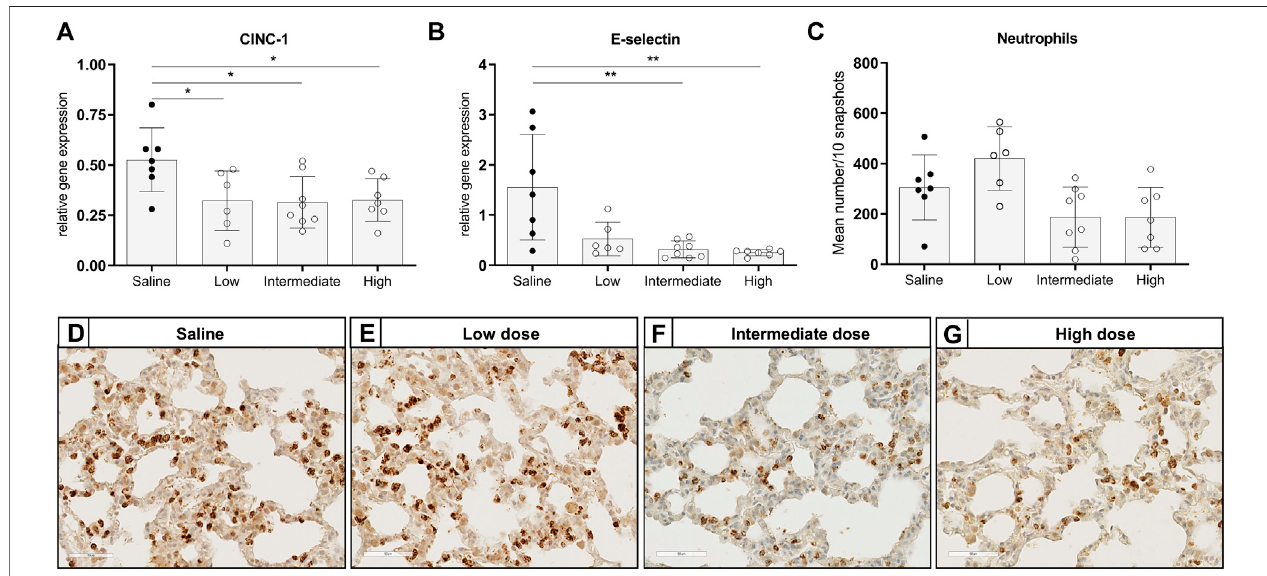
FIGURE 2 | Chemotaxis of neutrophils and in fi ltration of activated neutrophils in lung tissue. Brain death (BD) was induced in rats assigned to one of four experimentalgroups,etc.and1 hafterBDinductionratsweretreatedintravenouslywith1)0.9%saline(control)2)lowdosemethylprednisolone(5 mg/kgofbodyweight (BW), 3) intermediate dose methylprednisolone (12.5 mg/kg of BW) and 4) high dose methylprednisolone (22.5 mg/kg of BW). mRNA gene expression levels of (A) IL8- likeCINC-1and (B) E-selectin,involvedinchemo-attractionofneutrophils.Dataareshownasexpressionsrelativetohousekeepinggene β -actin. (C) Quanti fi cation of activated, MPO-stained neutrophils in lung tissue, presented as mean count per 10 random fi elds. (D – G) : Representative snapshots of lung slides stained for MPO. Values are presented as mean ± SD. * p < 0.05, ** p < 0.01.